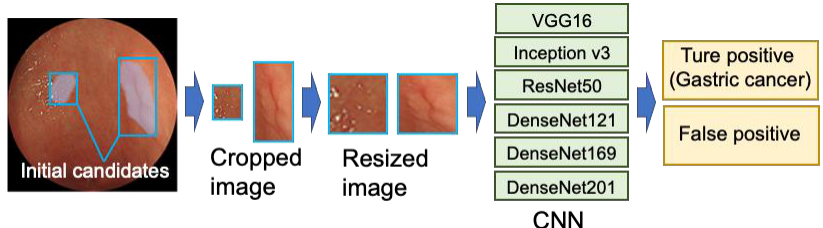
Figure 3. Architecture of the box classification.